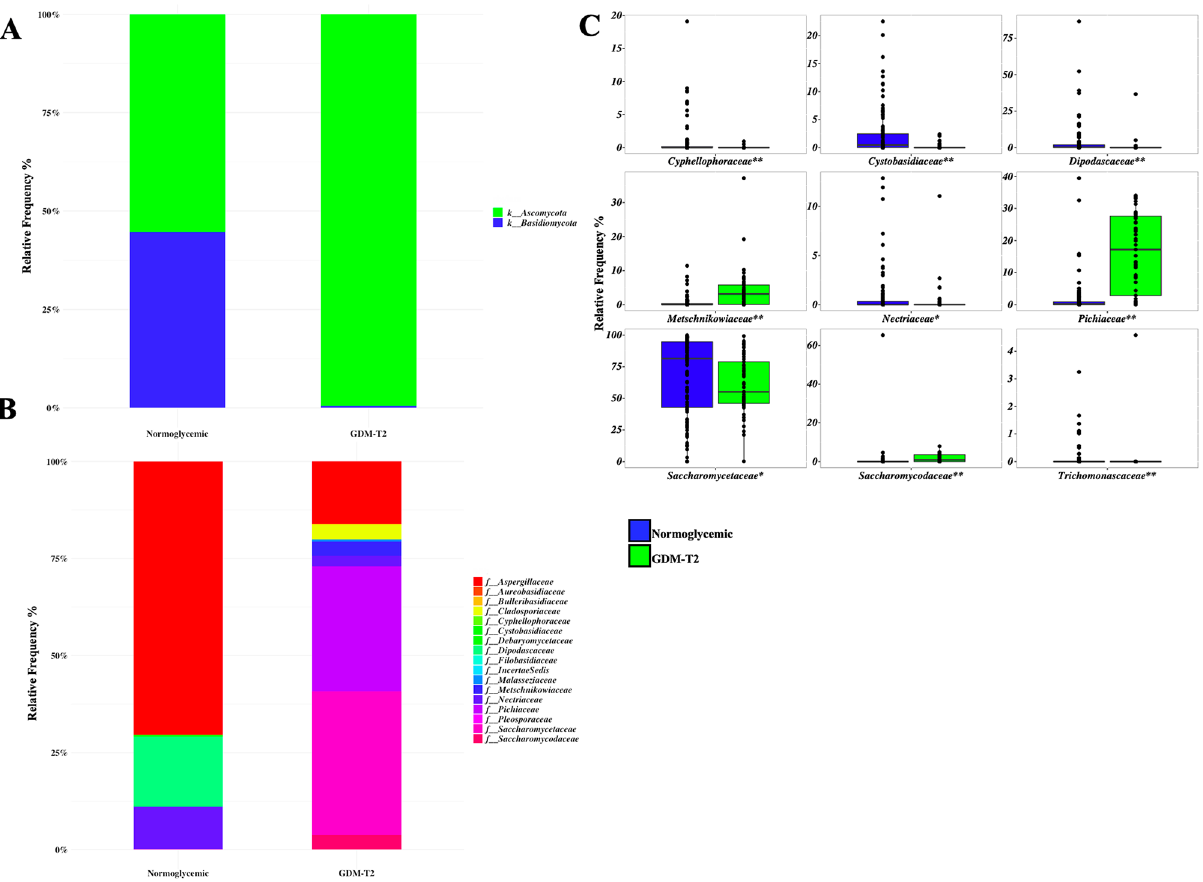
Figure 2. Plot A and Plot B: Global composition of mycobiota at phylum ( A ) and family levels ( B ) during the second trimester of pregnancy in normoglycemic and GDM women. Only ASVs with with a relative frequency > 1% in at least 10% of subjects are shown. Normoglycemic or GDM participants are labelled on the x-axis and expressed as the relative Amplicon Sequence Variants (ASVs) frequency. Plot C: boxplots of the ASVs at family level which were significantly different between normoglycemic and GDM women (Mann–Whitney test, * p < 0.05; ** p <